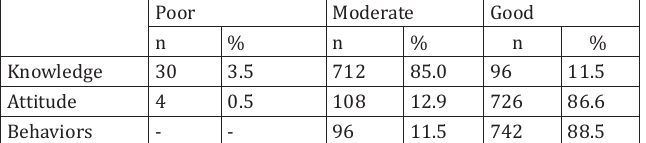
Distribution of participants' knowledge, attitudes and behaviors towards COVID-19